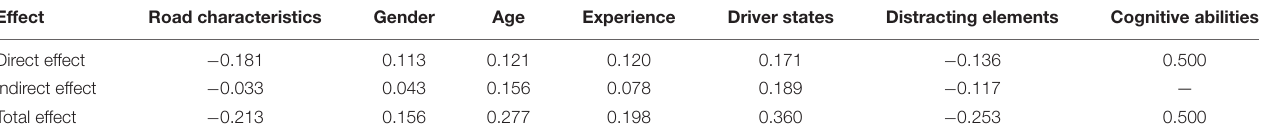
TABLE 7 | Effects of various factors on